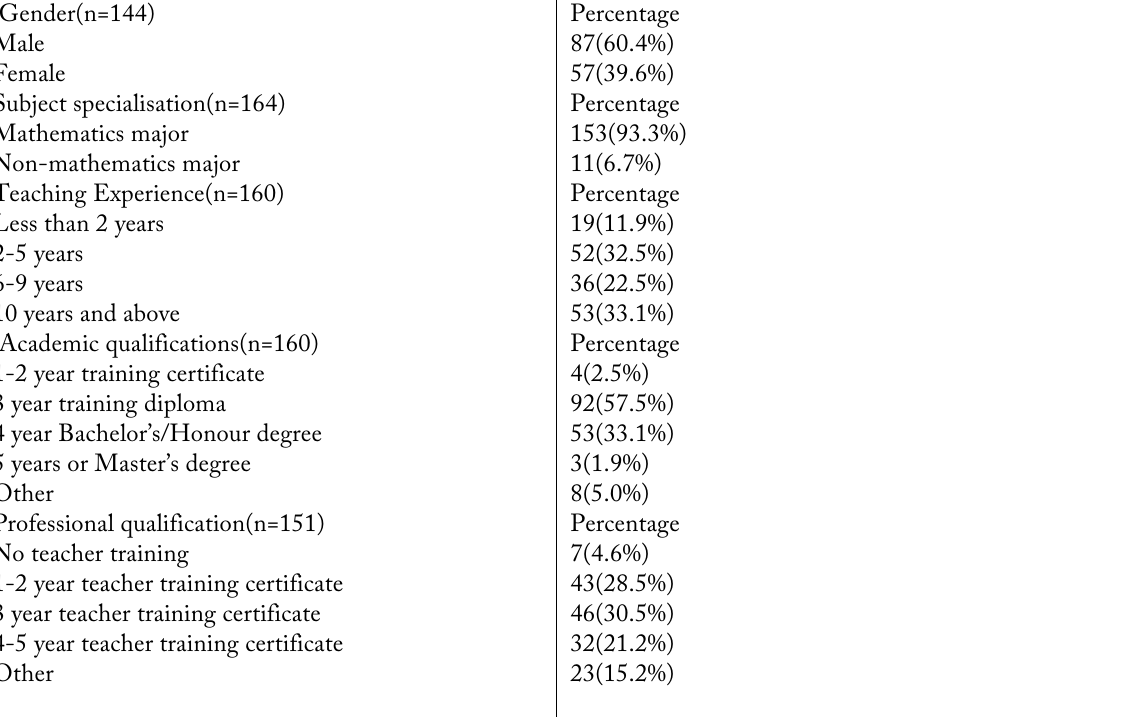
Table 4: Demographic Characteristics of JSC Mathematics